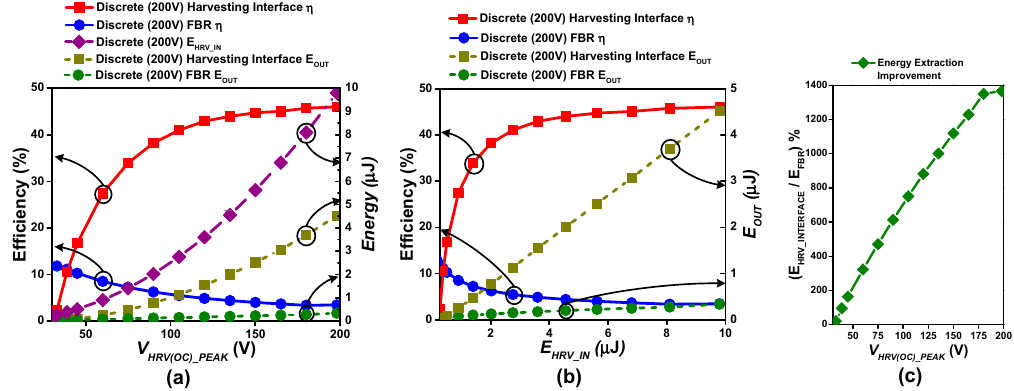
Figure 15. (a), (b) Efficiency comparison between the FBR and the discrete power switches version of the proposed harvesting interface at harvester open circuit voltage and input energy on x-axis respectively when harvesting from flexible piezoelectric harvester source (C P = 500 pF) under irregular excitation, at 3.3 V battery charging, (c) Energy extraction improvement w.r.t FBR.